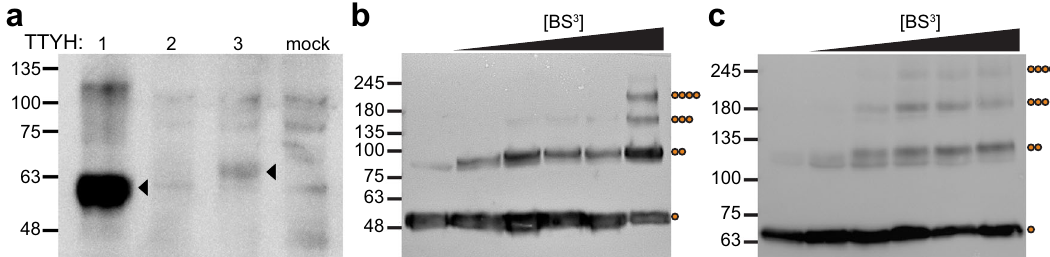
Fig. 1 In situ cross-linking analyses of mTTYH family members. a SDS-PAGE western blot analysis of HEK 293 cells transiently transfected with the indicated FLAG-tagged mTTYH paralogs. Arrowheads indicate the bands corresponding to mTTYH1 and mTTYH3. Note that there is a nonspeci fi c band in mTTYH2, which can also be found in non-transfected cells (mock). b , c SDS-PAGE western blot of mTTYH1 ( b ) and mTTYH3 ( c ) cross-linking with increasing concentrations of BS 3 (concentrations used were 0, 10, 50, 100, 200, and 2000 μ M from left to right). Molecular weights and oligomeric states are shown on the left and right,